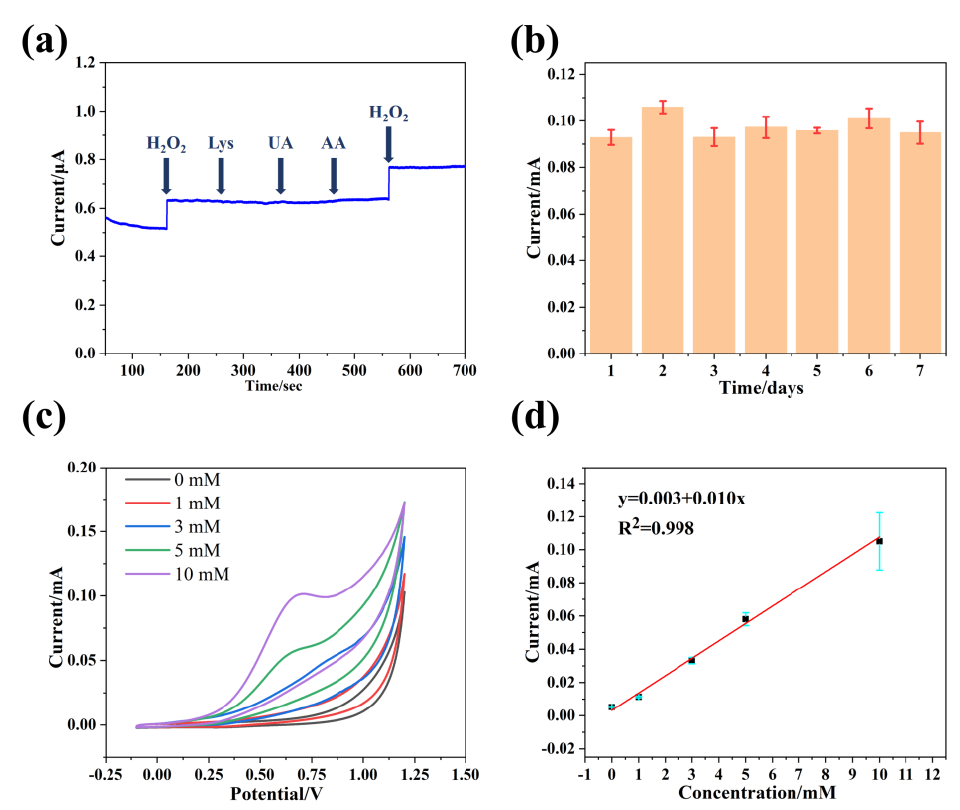
Figure 6. Anti-interference ability and stability of CuS-PNSs/Ti 3 C 2 -based electrochemical platform. ( a ) Amperometric responses upon successive additions of H 2 O 2 , Lys, UA, AA, and H 2 O 2 ; ( b ) stability of CuS-PNSs/Ti 3 C 2 electrochemical platform for 7 days; ( c ) current response of CuS-PNSs/Ti3C2/GCE toward H 2 O 2 with different concentrations of 0–15 mM in milk; ( d ) linear calibration of CV response with H 2 O 2 concentration from 0 to 15 mM in milk.